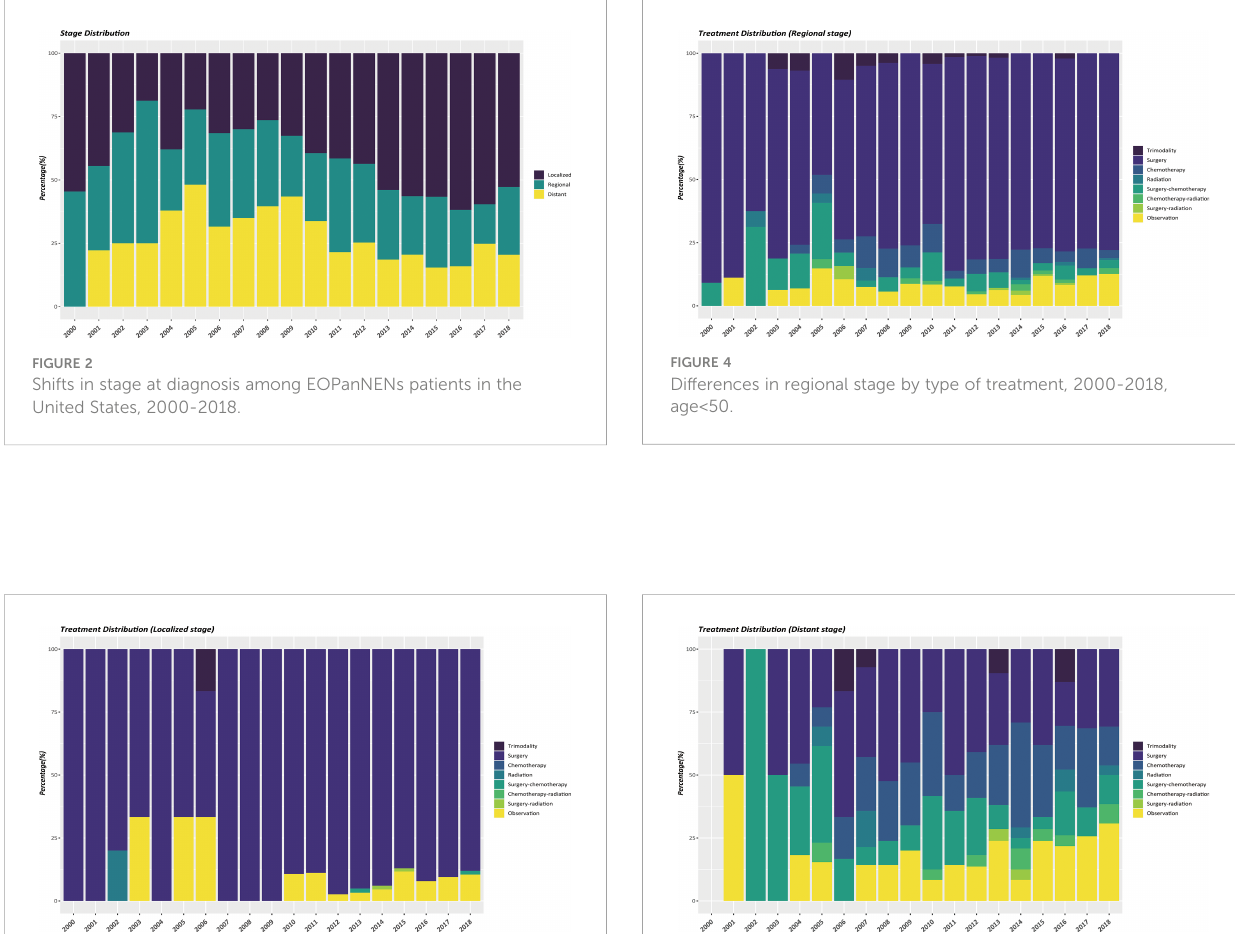
FIGURE 5 Differences in distant stage by type of treatment, 2000-2018,